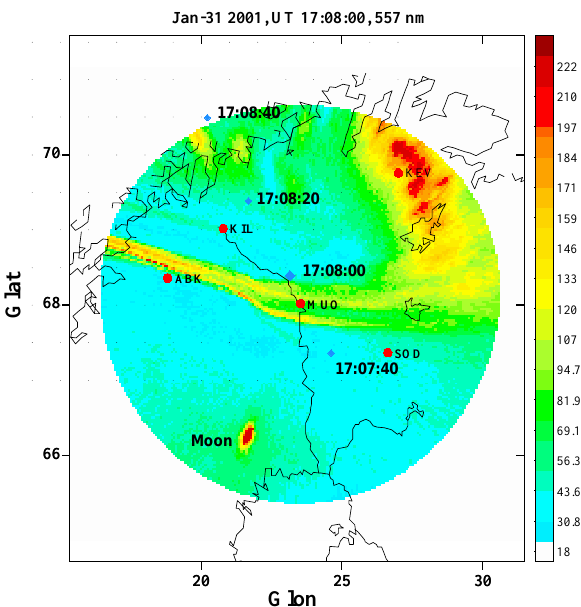
Fig. 1. A DMSP satellite pass over MUO ASC and an auroral arc on 31 January 2001 at 17:08:00UT. The green (557.7nm) line im- age is plotted on a geographical map in instrument units (ADU). The satellite footpoints (blue diamonds) are defined by the standard output from the Satellite Situation Center Web (SSCWeb) as traced along the magnetic field from the altitude of the satellite down to the altitude of 100km. The biggest diamond shows the satellite po- sition at